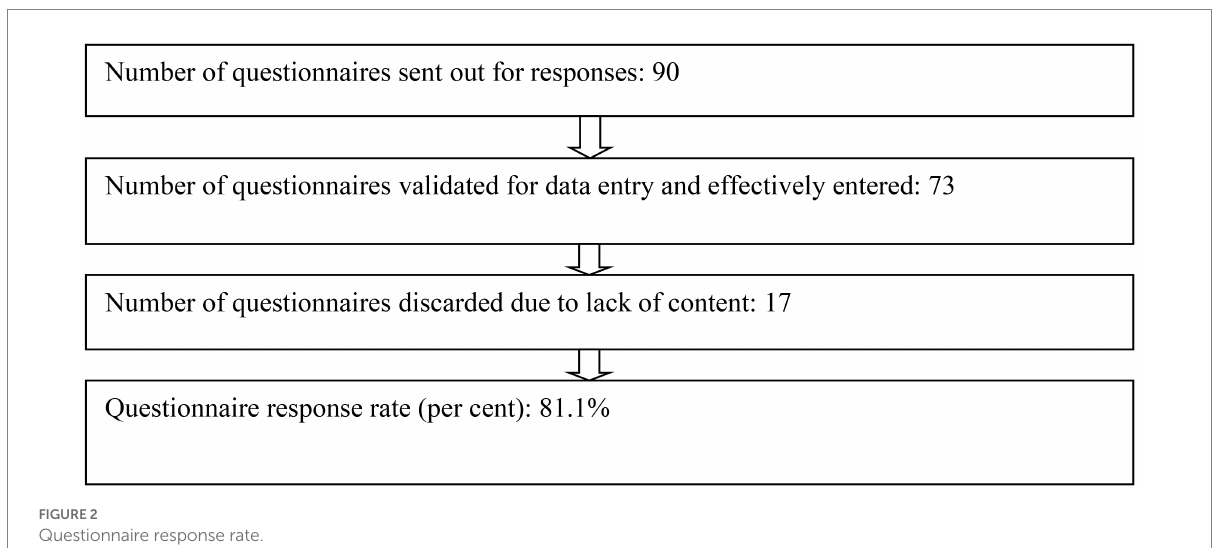
FIGURE 2 Questionnaire response